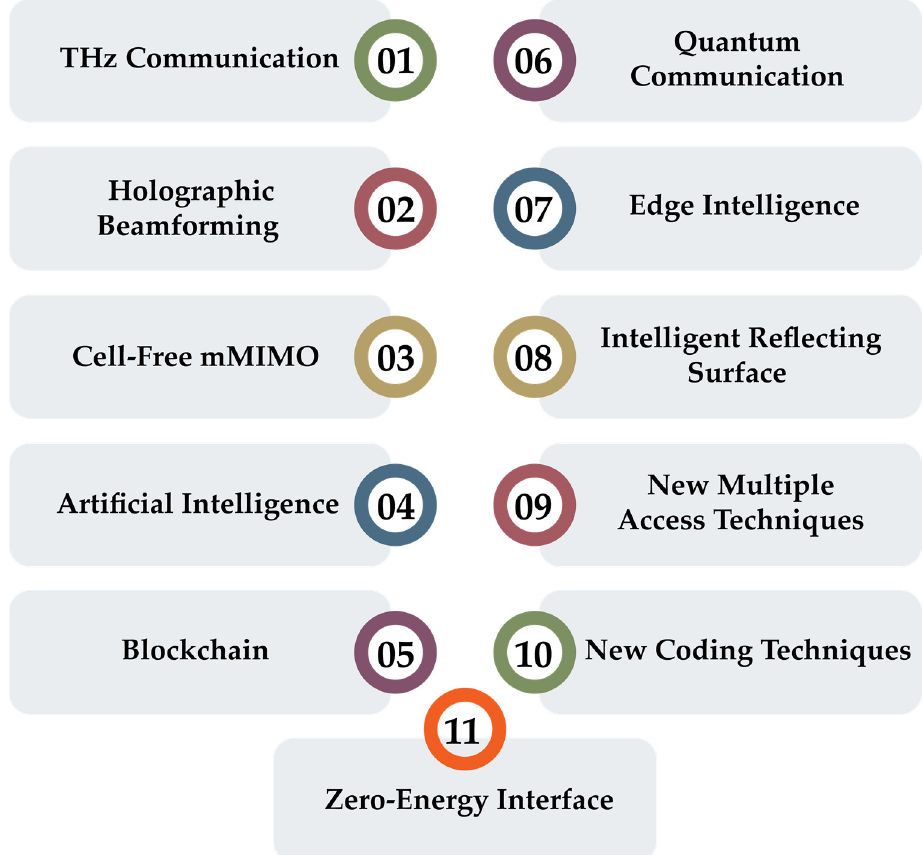
Figure 5. 6G key enabling technologies.